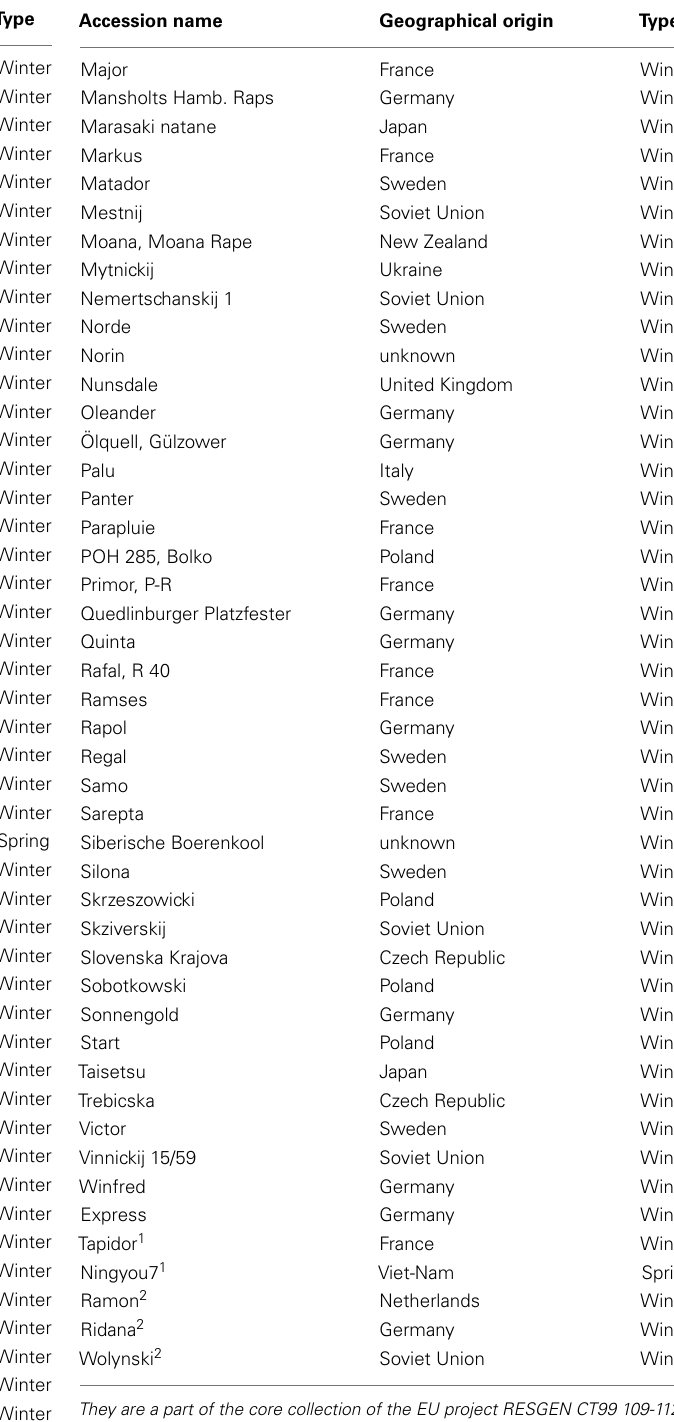
TableA1 | Brassica napus accessions which were used for field trials at Giessen and Holtsee (Germany)